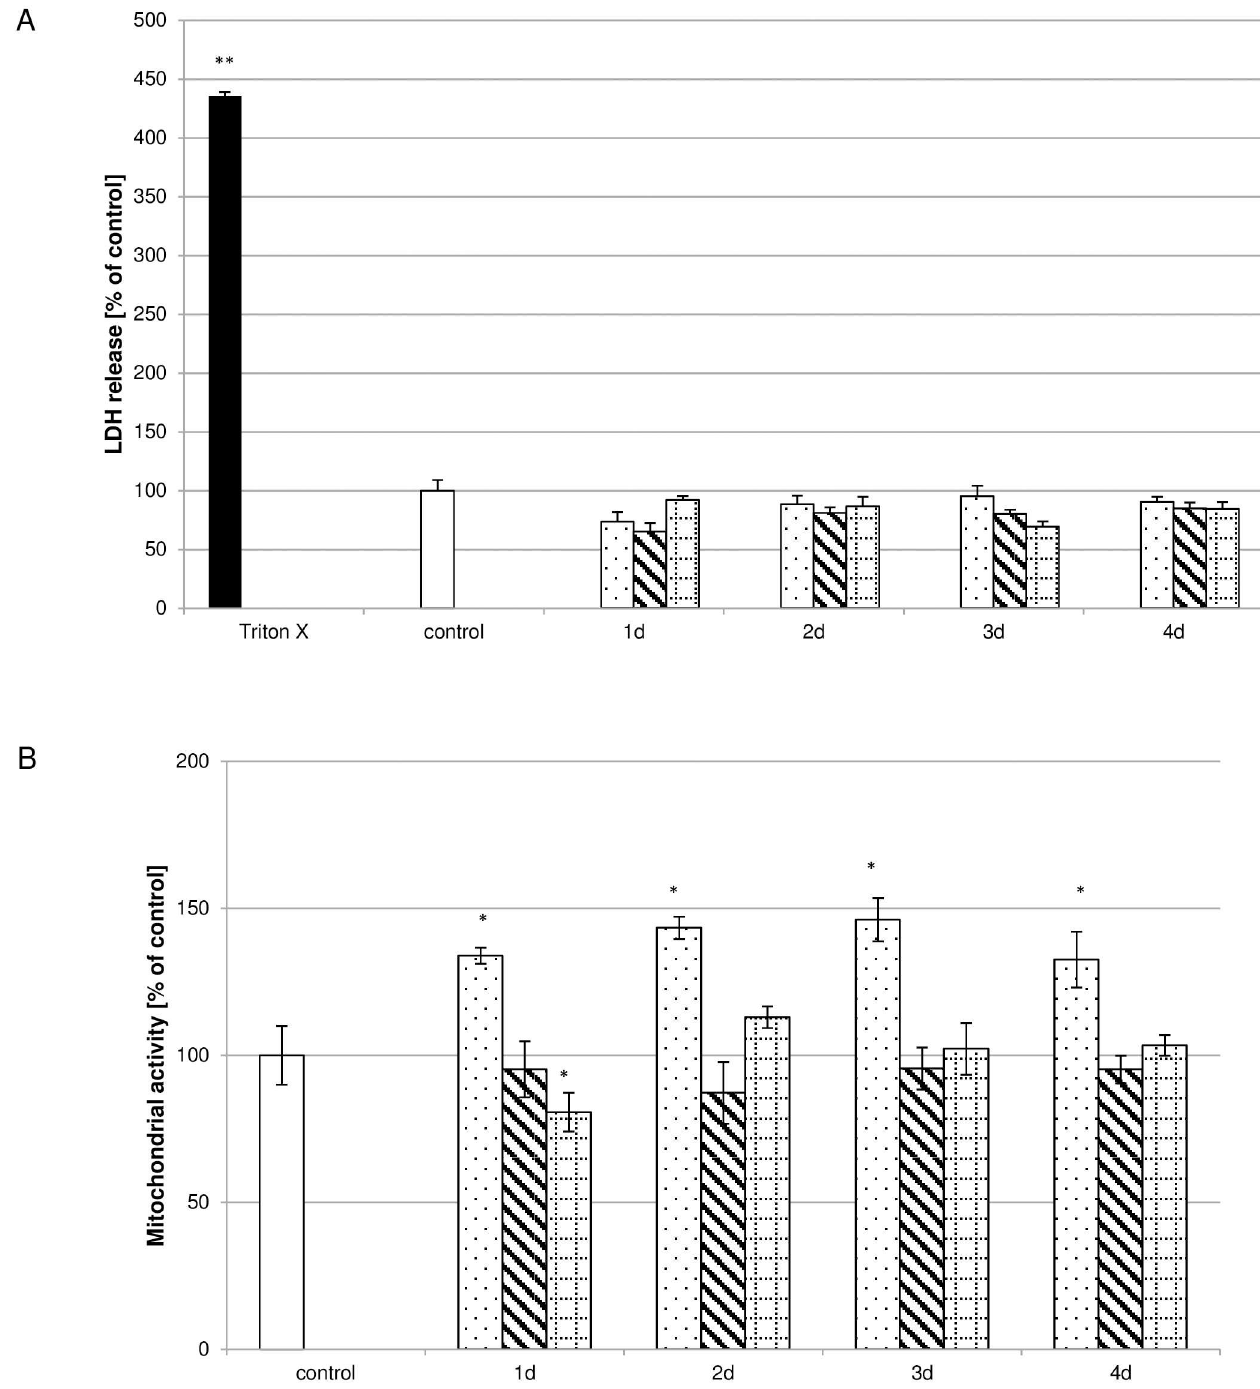
Fig 2. Biocompatibility of Biodentine ® suspensions. Cell integrity was monitoredby assayingLDH activity (A; N = 324). No influenceby the Biodentine ® suspensions of low (dotted bar), moderate (striped bar) or high (bricked bar) Biodentine ® concentrations on LDH activity could be observedin comparisonto the control (white bar). LDH activity of the Triton X-100 (black bar) treated cultures was significantly increased. Biodentine ® suspensions containinglow Biodentine ® concentrations increasedcell viabilitywhereassuspensionscontaining high Biodentine ® concentrations reducedcell viability(B; N = 270). The data displayedare representative of three independent experiments performed with comparable results. Average absorbance values (mean ± SD) from n = 6 replicates per experimental conditionwere calculated. * p (cid:20) 0.05; ** p (cid:20)